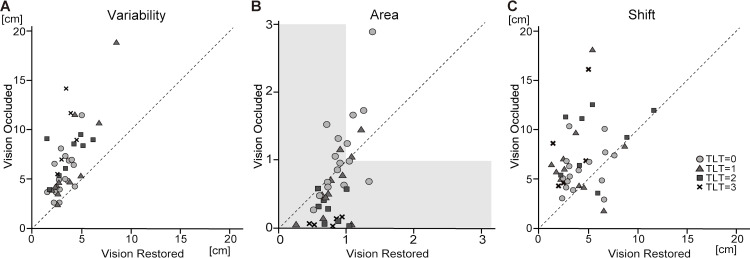
Scatterplots of robotic measures with vision occluded and with vision restored in each grade of the thumb localizing test (TLT).Scatterplots of (A)Variability, (B)Area, and (C)Shift are shown. The dots under the dotted line (y = x) indicate that the value is smaller with vision occluded than with vision restored, and the dots above the dotted line (y = x) indicate that the value is larger with vision occluded than with vision restored. The value of Area < 1 (gray shaded area) implies contraction and > 1 implies expansion of the workspace.